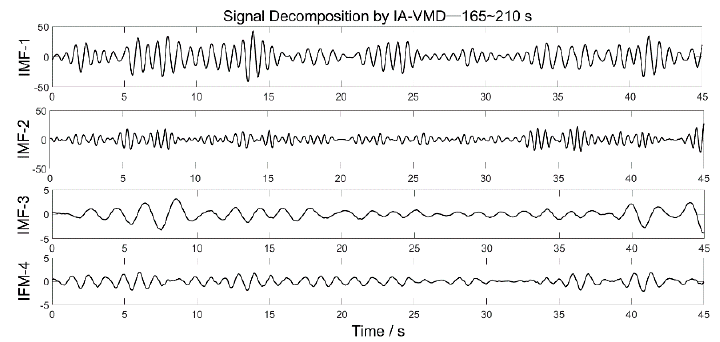
Figure 8. Intrinsic mode functions (IMFs) extracted from the obvious oscillation signal. Table 2. Modal identification of the obvious oscillation signal.